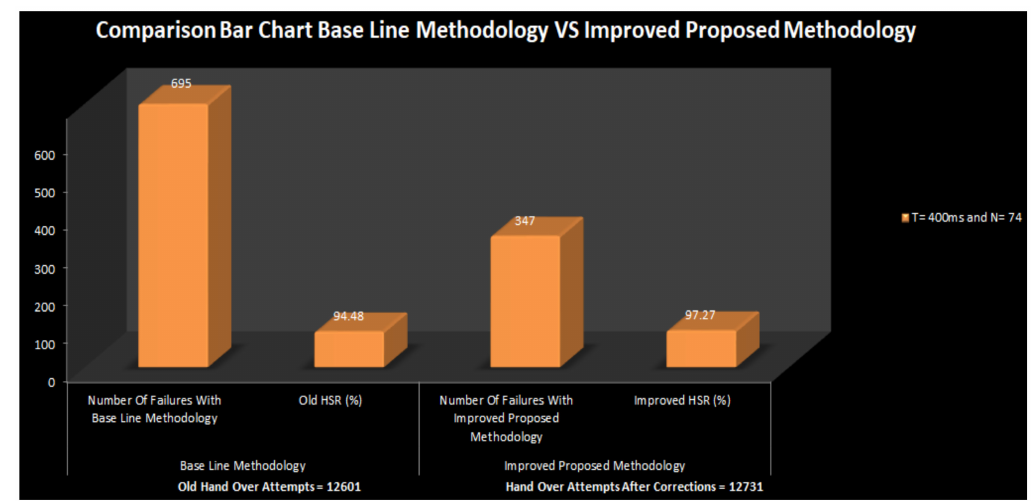
Figure 10. Population density graph for eight users.